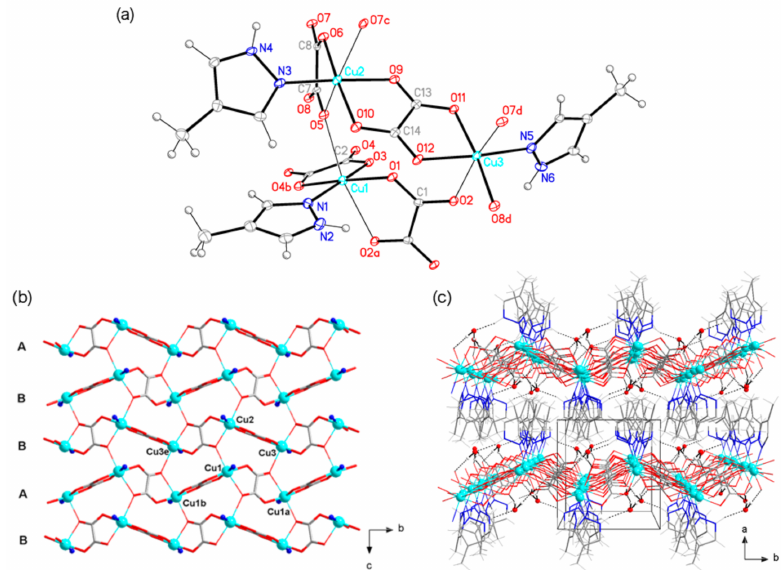
Figure 1. ( a ) Perspective view of a fragment of the neutral copper(II) layer of 1 with selected atom numbering. Thermal ellipsoids are drawn at the 30% probability level. ( b ) Projection of one corrugated oxalato-bridged copper(II) layer of 1 along the crystallographic a axis (terminal pyrazole ligands are omitted for clarity). The thinner solid lines represent the long Cu–O bond distances. ( c ) Perspective view of the crystal packing of 1 along the crystallographic c axis showing the zipper- type interpenetration of two parallel disposed layers. Hydrogen bonds are shown as dashed lines. Symmetry code: (a) = − x + 1, − y + 1, − z + 1; (b) = − x + 1, − y , − z + 1; (c) = − x + 1, y + 1/2, − z + 1/2;